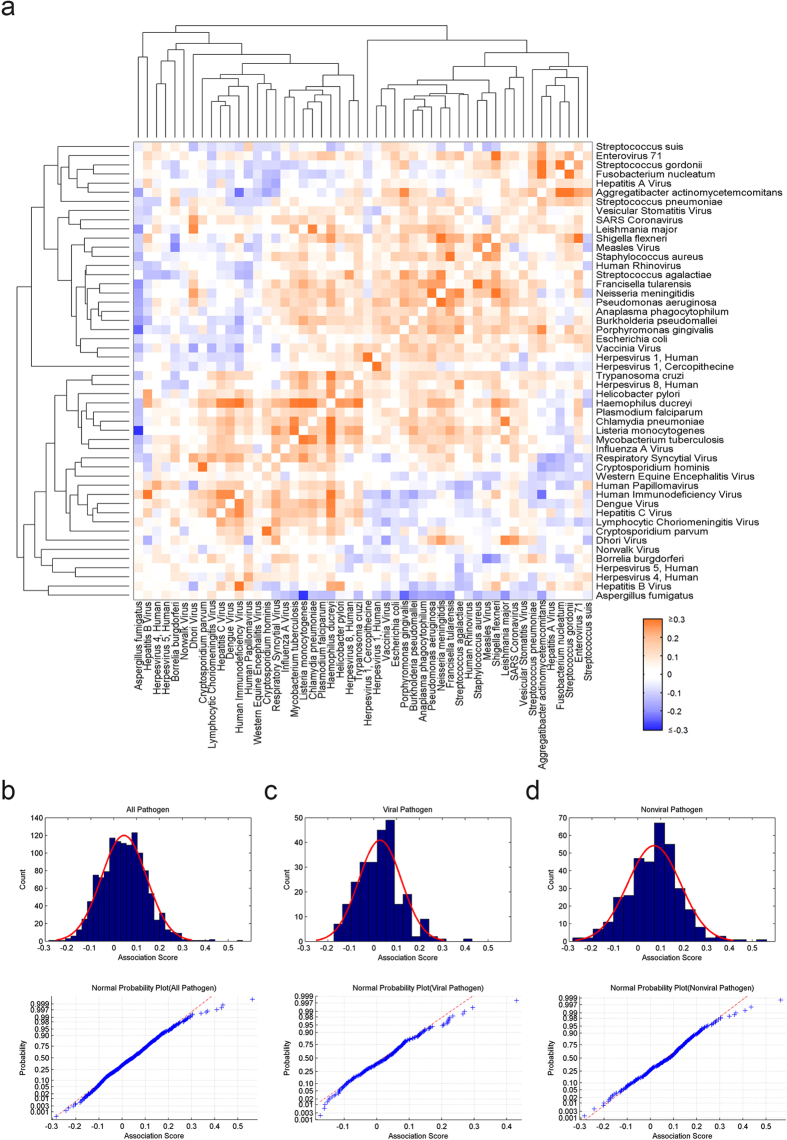
HTR Connectivity Map of 50 pathogens.(a) Heat map representation of association scores for HTR connectivities among 50 pathogens (a heat map of association scores calculated based on individual pathogen strain is in Supplementary Figure S1). The association scores among these 50 mPRLs are reported with corresponding P values and FDR values in Supplementary Data S5. The color of each cell represents the HTR connectivity association score computed for the mPRLs of each pathogen pair, with red representing positive connectivity and blue representing negative connectivity. Distributions of association scores for 1,225 pairs of HTRs among (b) all 50 mapped pathogens, (c) the 27 mapped non-viral pathogens (21 bacterial species, 5 protozoans, and 1 fungus), and (d) the 23 mapped viral pathogens, as approximated to normal distributions. All distribution patterns were in accordance with Gaussian distribution, and presented as means with standard deviations, i.e., 0.0447 ± 0.0987 (50 pathogens), 0.0711 ± 0.1153 (non-viral pathogens), and 0.0278 ± 0.0931 (viral pathogens). All distributions deviated from their expected zero centers (P = 7.67 × 10−52, 1.07 × 10−26, and 1.70 × 10−6 for all 50, non-viral subset, and viral subset, respectively, two-sample t-tests).